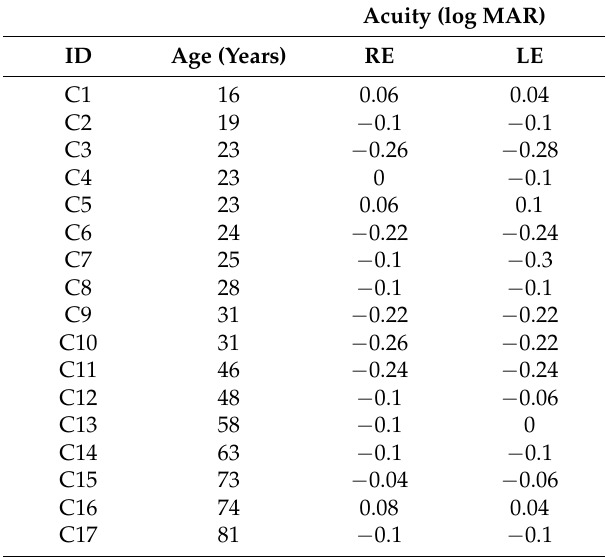
Table 2. Demographic characteristics of the control